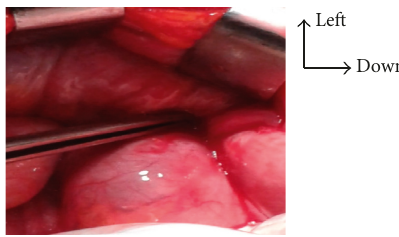
Figure 6: Adhesion of the ilium to the left inguinal orifice.